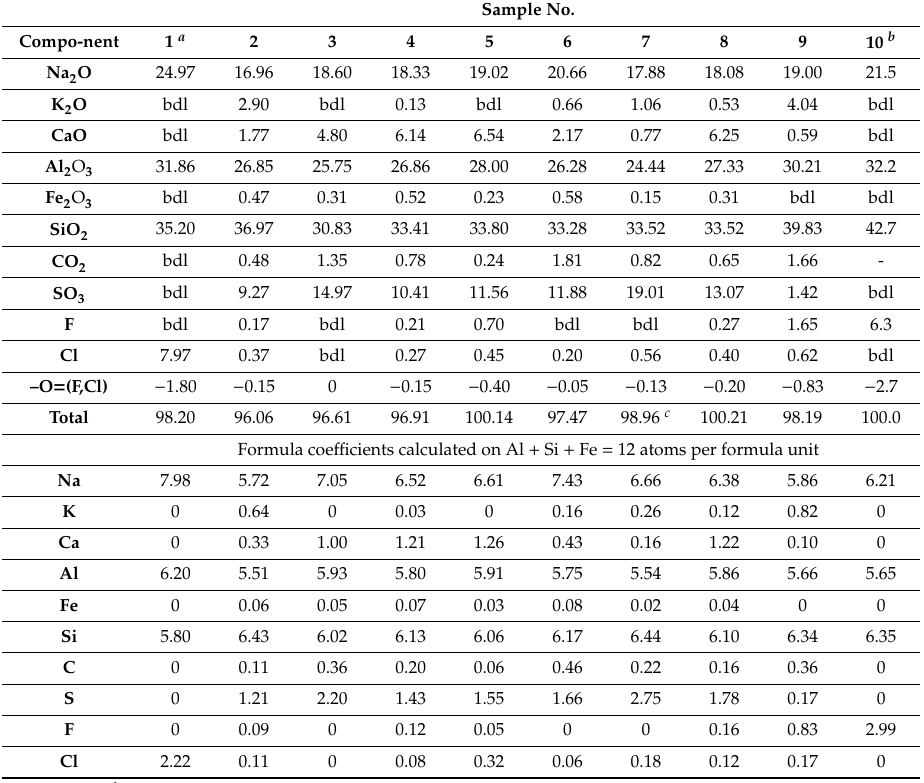
Table 3. Chemical composition of sodalite-group minerals. Sample